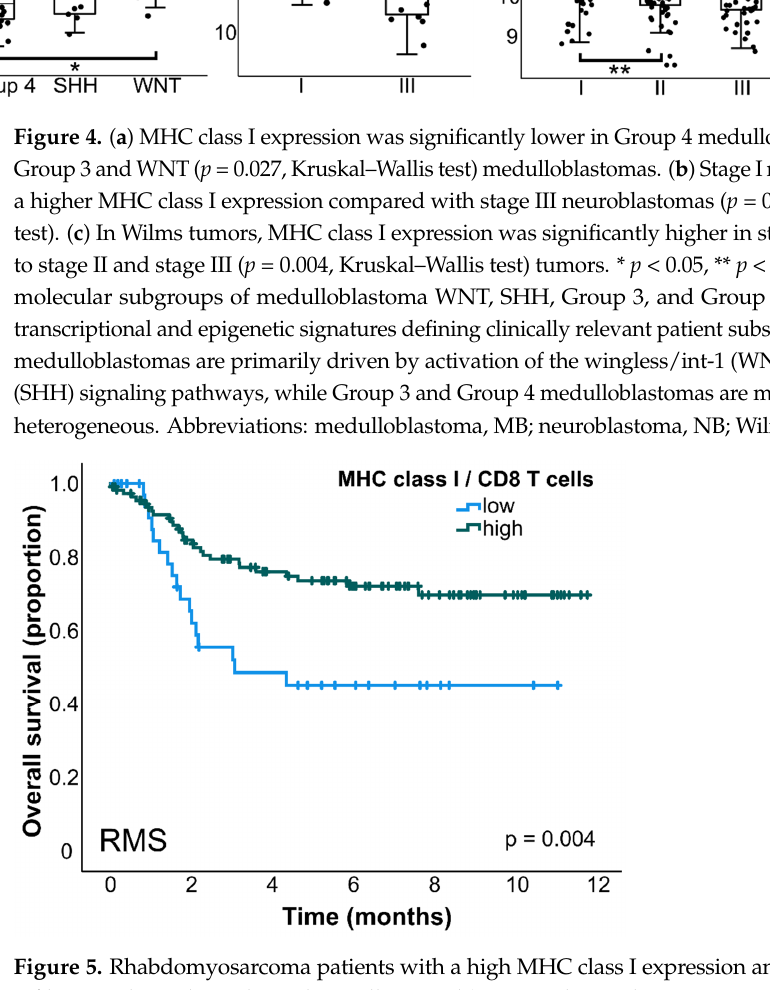
Figure 5. Rhabdomyosarcoma patients with a high MHC class I expression and abundant CD8 T cell infiltration showed a prolonged overall survival ( p = 0.004, log ‐ rank test, GSE92689, n =